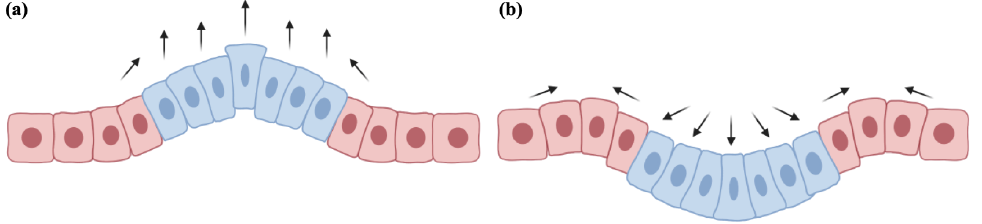
Figure 1. Heterogeneous growth. ( a ) A cluster of cells growing faster than its surroundings could cause the loss of cell–cell adhesion. ( b ) Rearrangement of growth and pressure affects both mutant cluster cells and adjacent